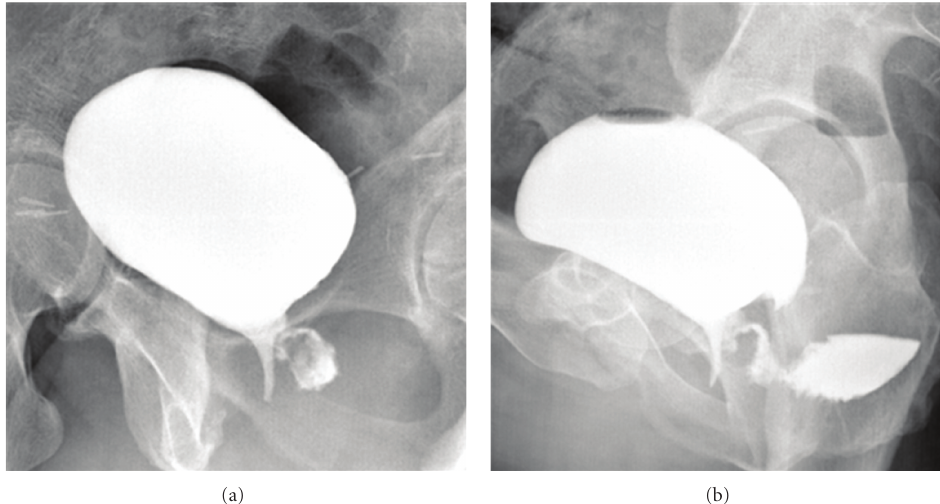
Figure 1: Retrograde cysto-uretrography. Oblique radiograms of bladder after full repletion with contrast media (a and b). The expansion of contrast media could be better observed in the oblique projections (a), especially when acquired after the space of a few minutes (b). In delayed oblique projection, as shown fistulous tract was more visible, as well as a certain amount of contrast in the rectum. It was not, however, possible to exclude with absolute certainty a partial involvement of the bladder.